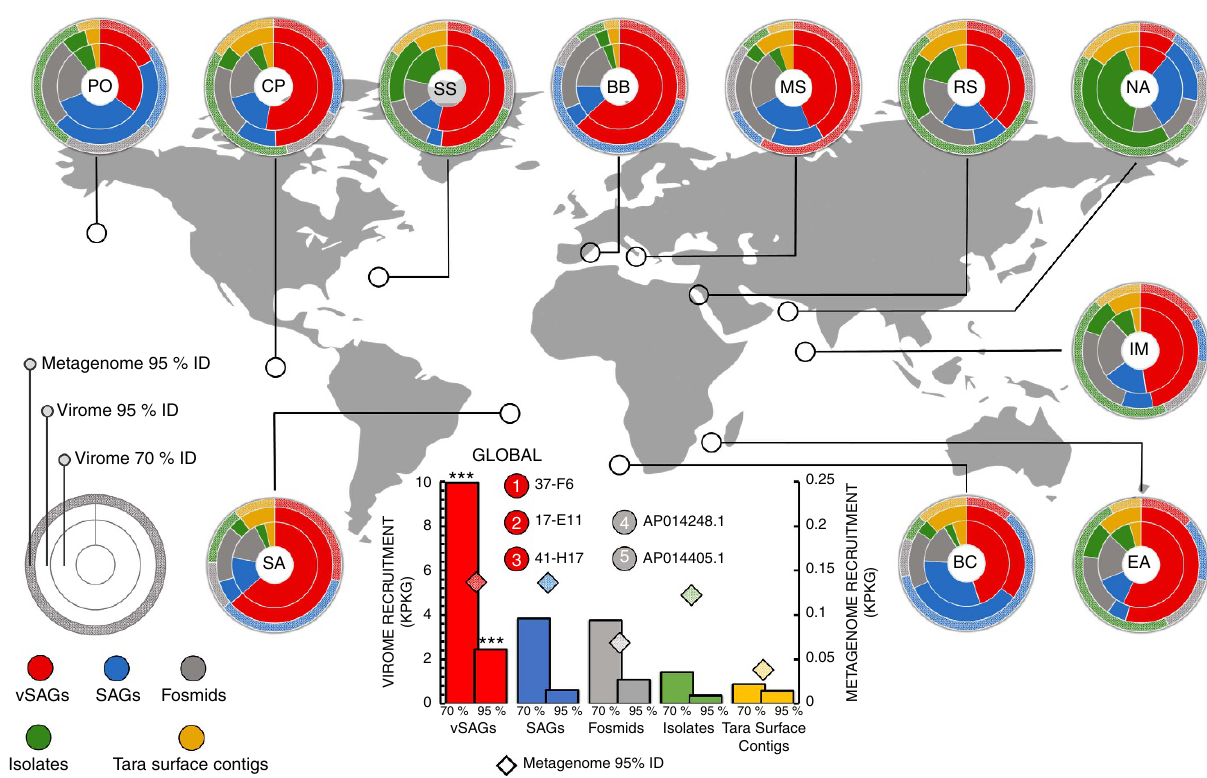
Figure 2 | Relative abundance and distribution of surface marine viruses. Virome and microbiome metagenomic fragment recruitments of marine viruses in each ocean. Rings represent the relative microbiome and virome recruitment frequency for each genomic data set, corresponding to the relative abundance of viral populations. External ring is for the microbiome recruit by using Z 95% nucleotide identity threshold (species level). Inner and medium rings depict the virome recruitment at two different nucleotide identity cut-offs, Z 70% and Z 95%, corresponding to the genus and species levels, respectively (Supplementary Fig. 10 and Supplementary Notes 4 and 5). Viral genomic data sets used were: 40 surface vSAGs (this study), 179 reference virus isolates (Supplementary Table 9), 1,148 viral fosmids 10 , 20 viral genomes from uncultured prokaryotic single cells 26 and 3,018 surface viral contigs